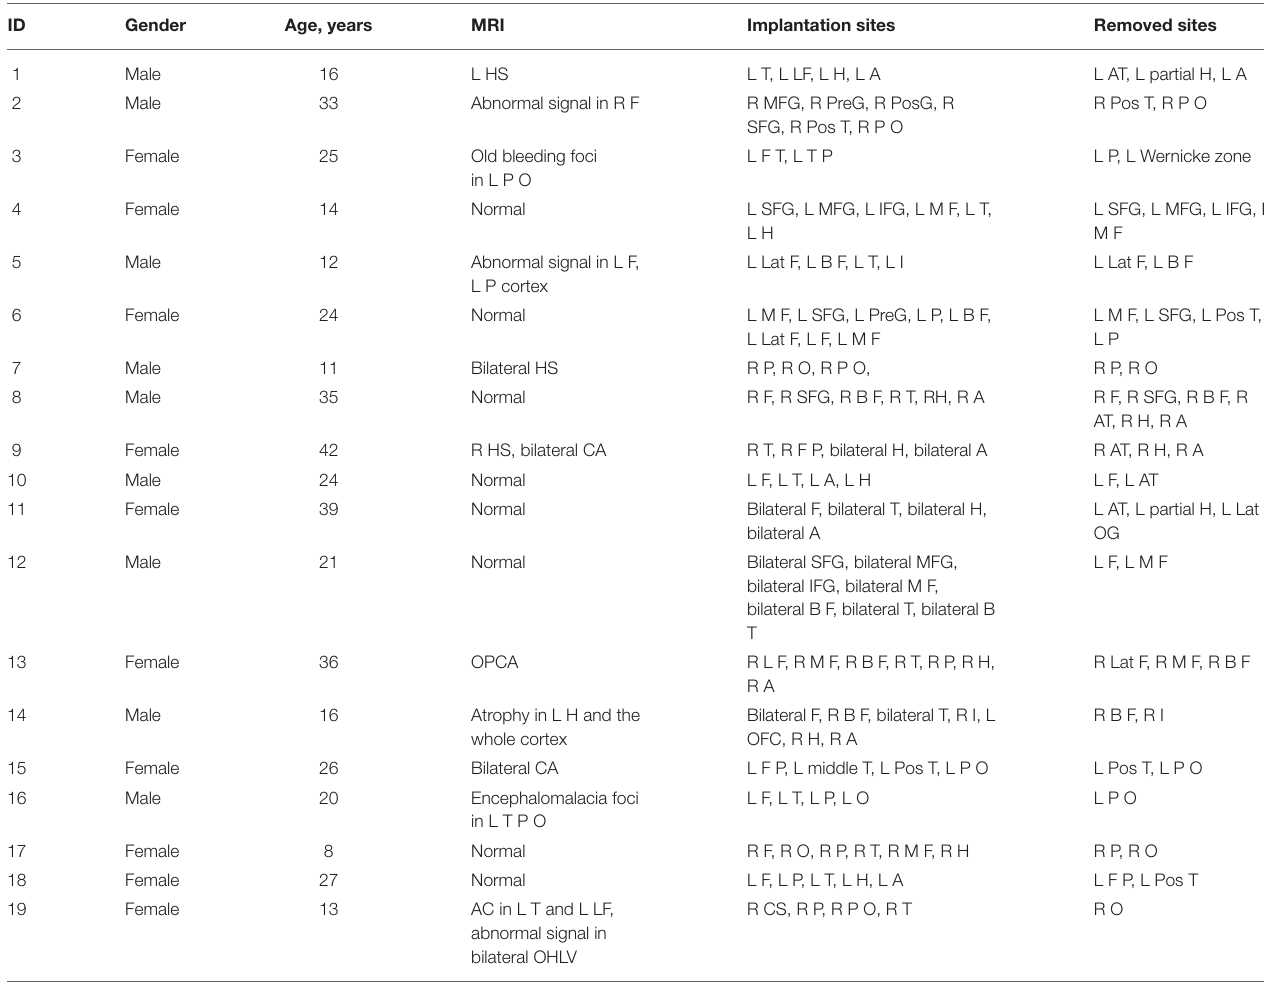
TABLE 1 | Demographics and clinical